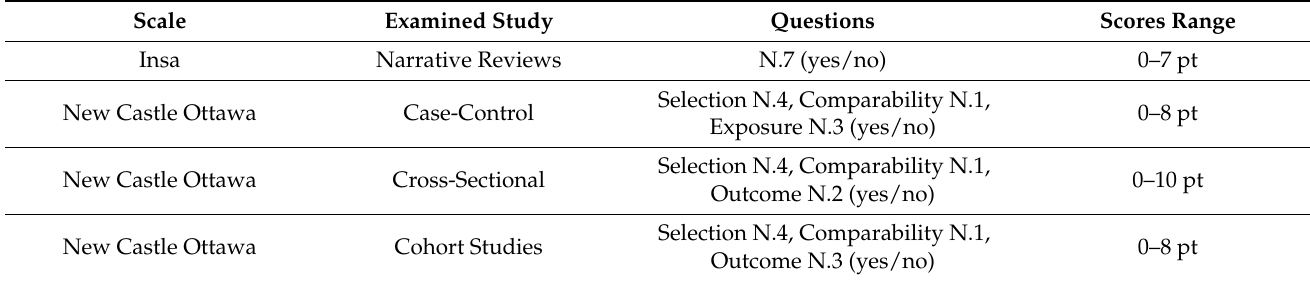
Table 1. Tools for assessing the quality of studies included in this systematic review.